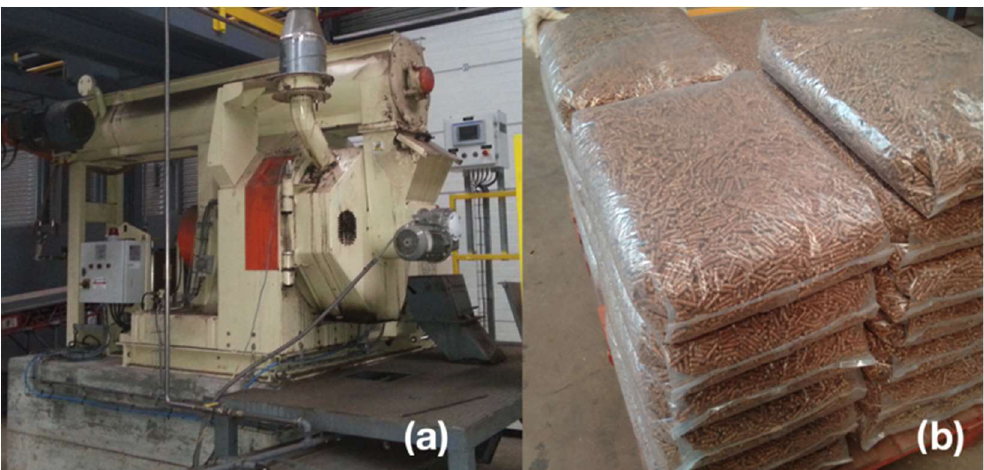
Figure 3. The production of pellets in industrial scale test. ( a ) The equipment used in the test: a LaMeccanica pelletizer with a production of 1200 kg/h; and ( b ) the produced pellets bagged and ready to be consumed in domestic equipment.